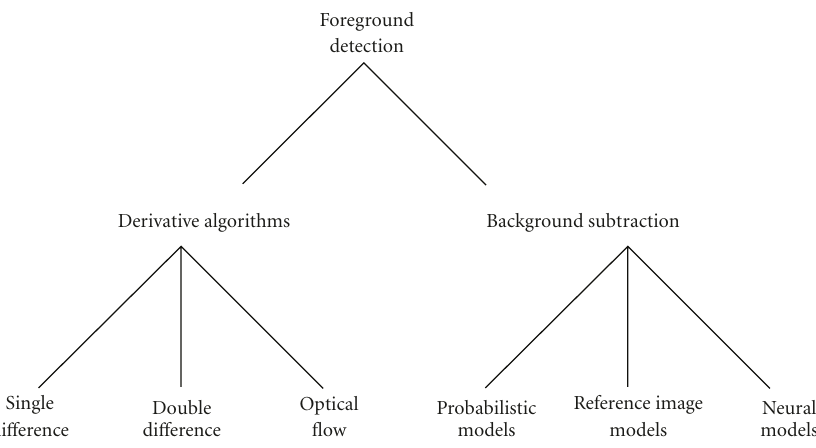
Figure 1: Foreground detection algorithms